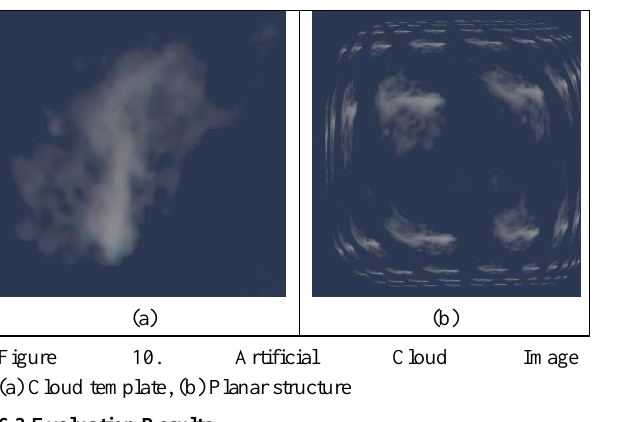
Figure 10. Artificial Cloud Image (a) Cloud template, (b) Planar structure